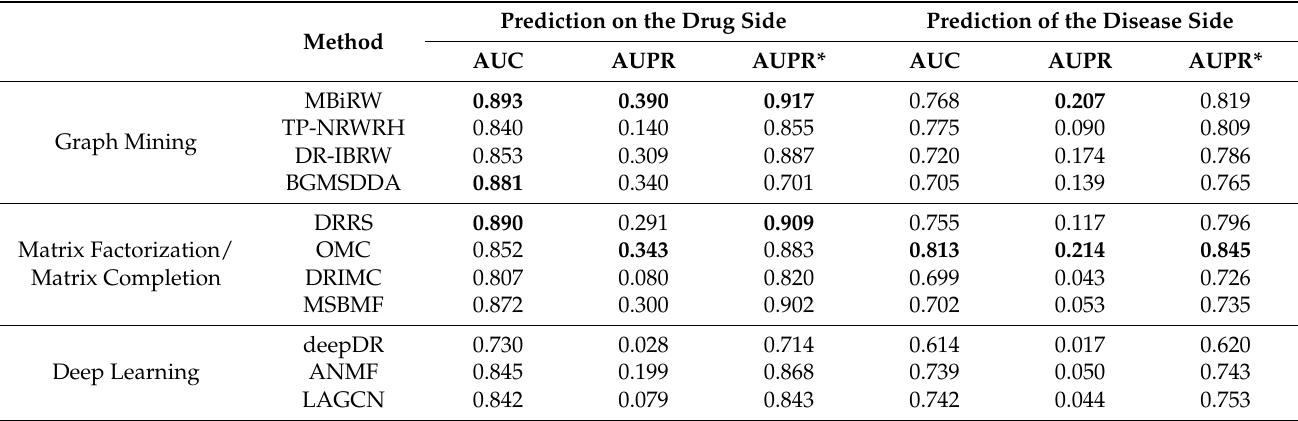
Table 4. AUC, AUPR, and AUPR* of drug–disease association prediction results using network-ATC. Values close to the highest are expressed in